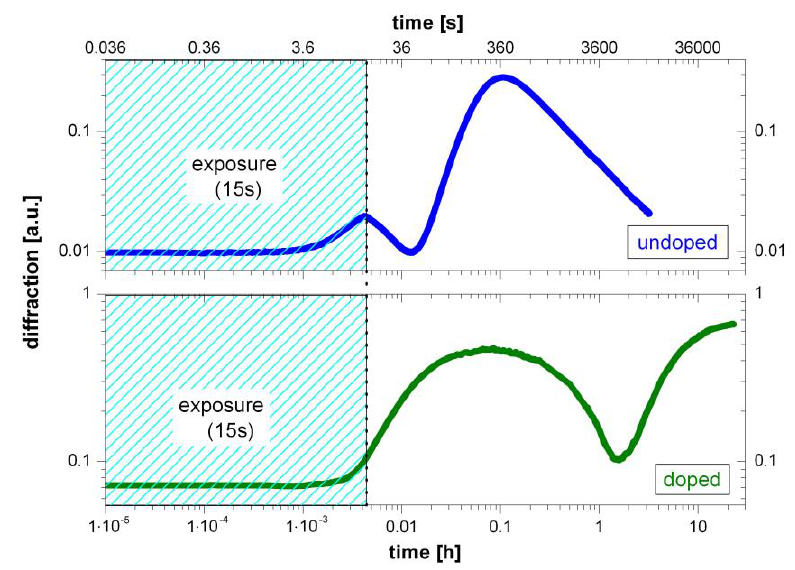
Figure 2. Volume holographic grating growth: Comparison of growth curves from the undoped ( top ) and doped system ( bottom ) on double logarithmic scales. Exposure duration was 15 s in each case.